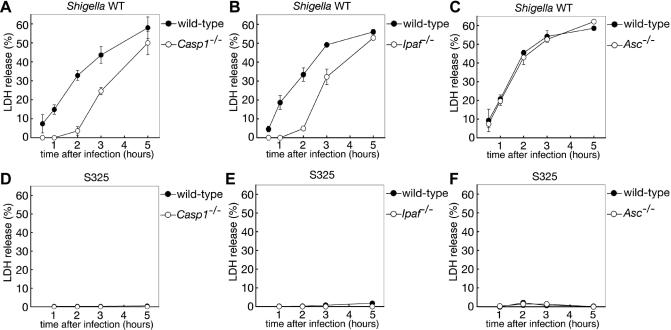
The Early Phase of Pyroptosis Induced by Shigella Is Dependent on Ipaf but Not ASCCaspase-1-deficient (A and D), Ipaf-deficient (B and E), or ASC-deficient BMMs (C and F) were infected with Shigella WT (A–C) or TTSS mutant S325 (D–F). LDH released from infected BMMs were quantified at the indicated time. Error bars represent mean ± SD.